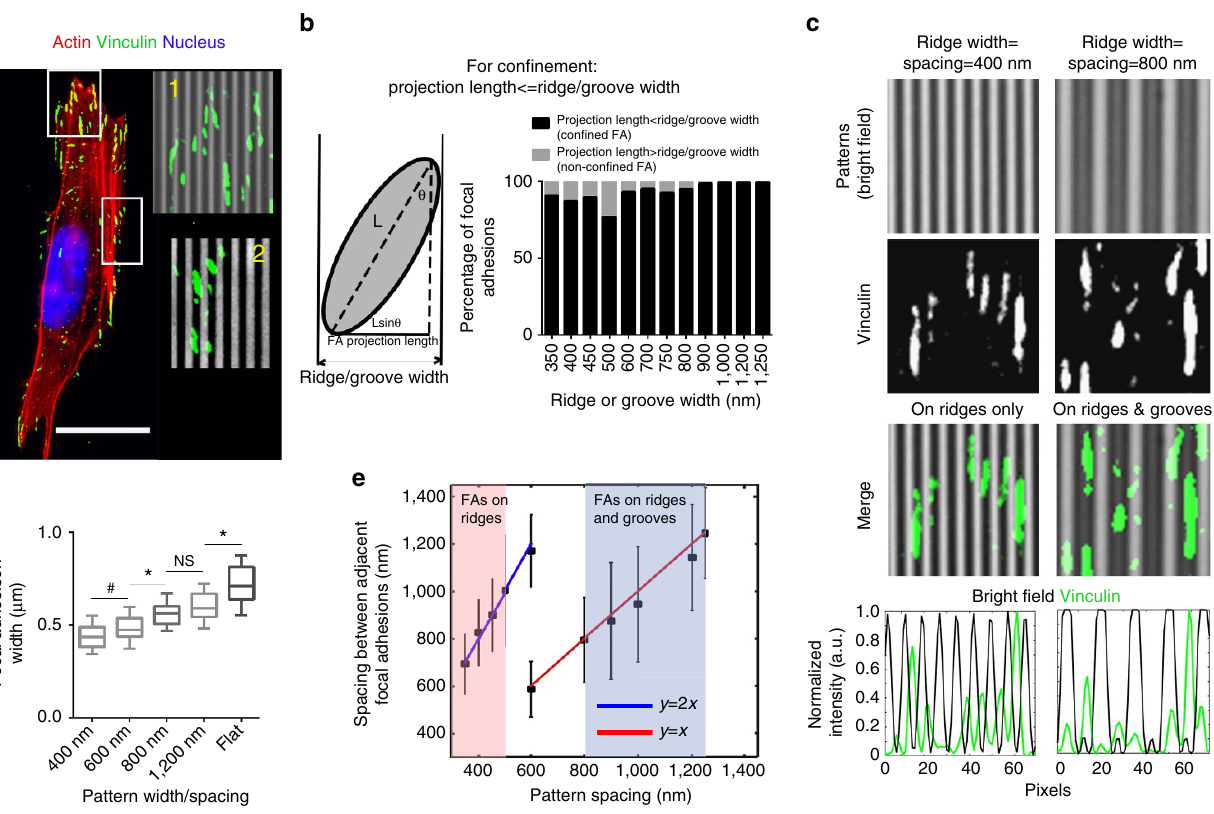
Figure 3 | Spatial constraints from aligned topographies direct focal adhesion orientation as well as elongation and biased distribution. ( a ) Representative fluorescence micrograph showing a typical MDA-MB-231 cell aligned on a nanopatterned substrate stained for actin (red), Vinculin (green) and nucleus (blue); scale bar, 20 m m. (inset-1 for top box) Magnified region demonstrating high FA alignment and magnified side region (inset-2 from side box) showing non-aligned Vinculin-stained FA complexes (green) overlaid on the nanopatterns from bright-field image (grey). ( b ) Schematic diagram showing the projection length of an ellipsoidal FA complex confined within a nanopattern ridge or groove and analysis of FA complexes on patterns of varying ridge and groove widths, where the ridge and groove width dimensions are equal for each condition (that is, 1:1 ratio), demonstrating that the vast majority of FAs have projection lengths less than the corresponding pattern dimensions. ( c ) Overlaid bright-field micrographs of nanopatterns (grey) and fluorescence micrographs of Vinculin (green) showing typical adhesion complex distribution on patterns with 1:1 ridge ¼ groove width (for example, 400nm:400nm on the left and 800nm:800nm on the right) with average line intensities for each along the corresponding abscissa demonstrating FA confinement to individual ridges and grooves. ( d ) Widths of large, aligned FA complexes at the leading edge of cells on aligned substrates increase with increasing pattern widths and are higher still on flat substrates ( n 4 65 per group). ( e ) Peak-to-peak distances or spacing between adjacent FAs as a function of pattern width/spacing highlighting the discrete arrangement of FA positions. Pink and blue highlighted regions respectively denote pattern width ranges where adjacent FAs form on consecutive ridges only and on both ridges and grooves, as inferred from the slope of their linear relationship to the pattern widths. Data are median with 10–90th percentile range ( d ) and mean ± s.d. ( e ). # P o 0.05, * P o 0.001, NS ¼ no significance